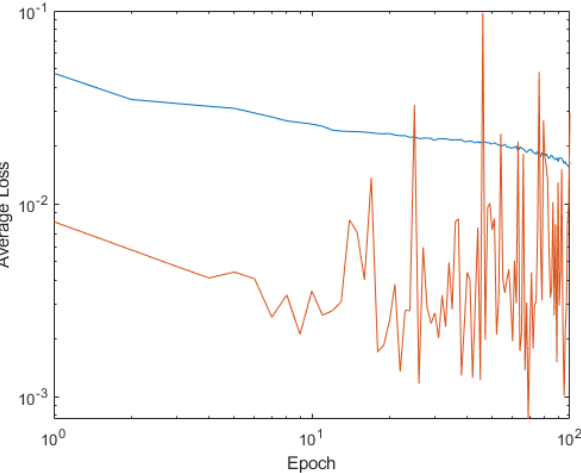
Figure 19. Average loss on training patterns in blue and validation patterns in orange for Dynamic